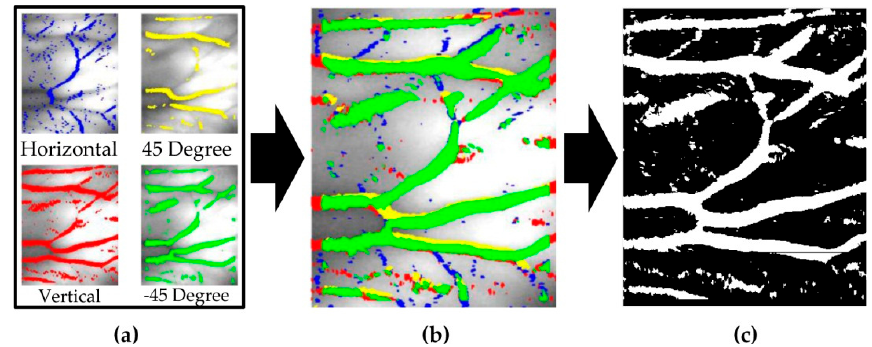
Figure 12. Vein image detection: ( a ) Results from four directional intensity profiles; ( b ) combined vein image; ( c ) final classified vein image.